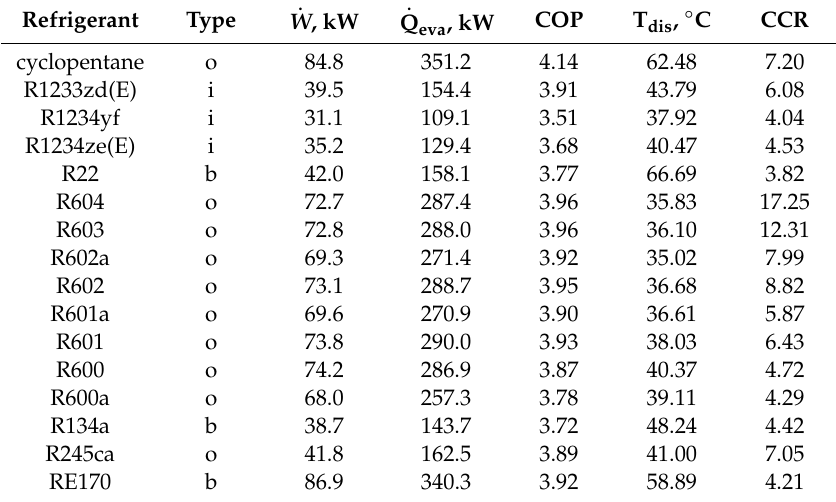
Table 3. Results for VCRC using investigated pure refrigerants.